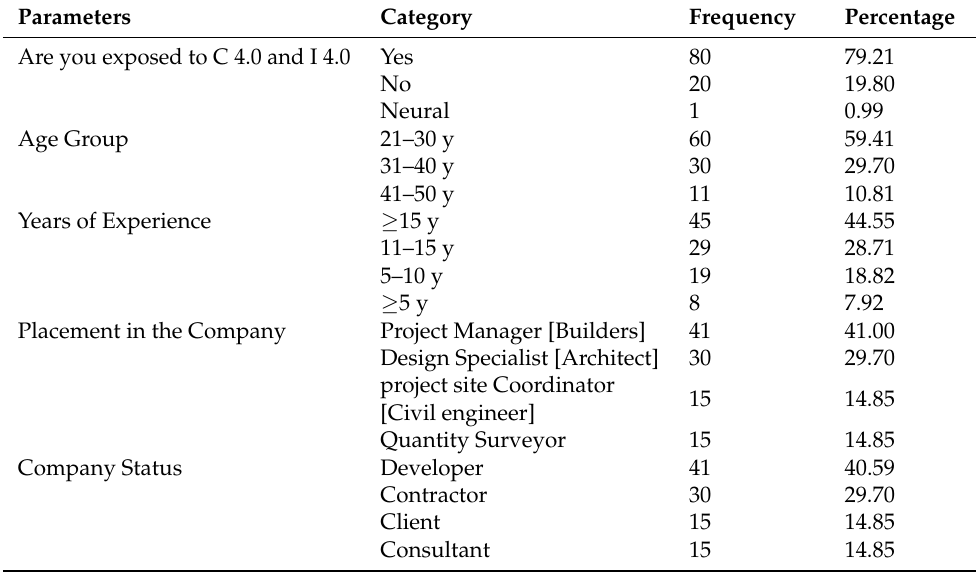
Table 1. Bio-data information of respondents.